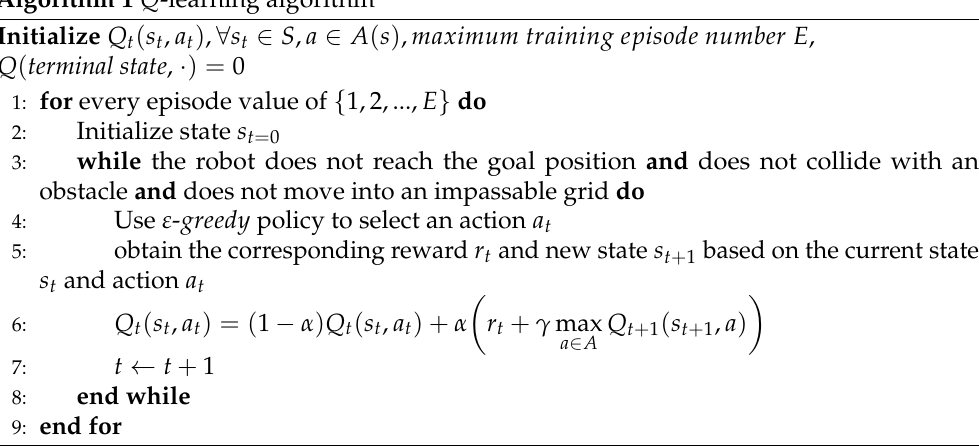
Algorithm 1 Q -learning